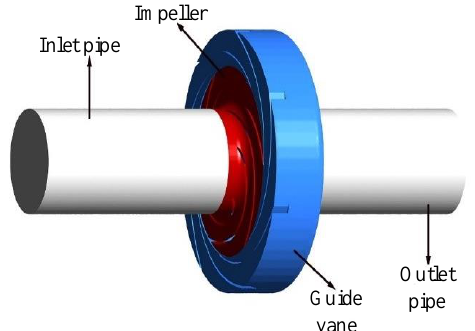
Figure 2. Exploded view of the research object.